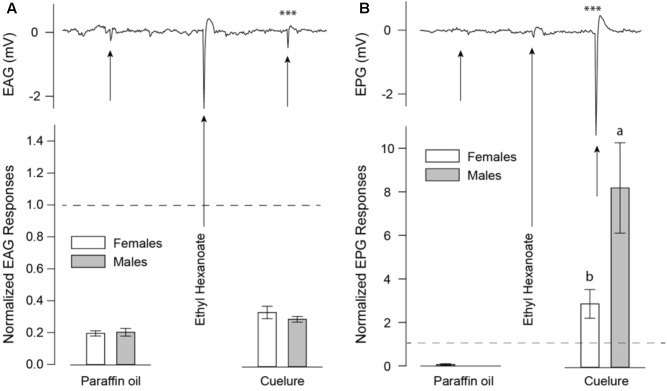
Electroantennogram (EAG) (A) and electropalpogram (EPG) (B) of Bactrocera tryoni responding to paraffin oil as a blank control, ethyl hexanoate as a positive control, and cuelure. Black arrows on the EAG (n = 8) and EPG (n = 7) traces indicate chemical stimulations. White bars represent normalized responses of adult females and gray bars that of males with their standard errors. Letters above bars indicate statistical differences between male and female responses. Asterisks over the traces depict statistical differences of normalized responses compared with responses elicited by paraffin oil alone (∗∗∗P < 0.001). Dashed lines indicate baseline response of ethyl hexanoate used as positive control and reference for data normalization.